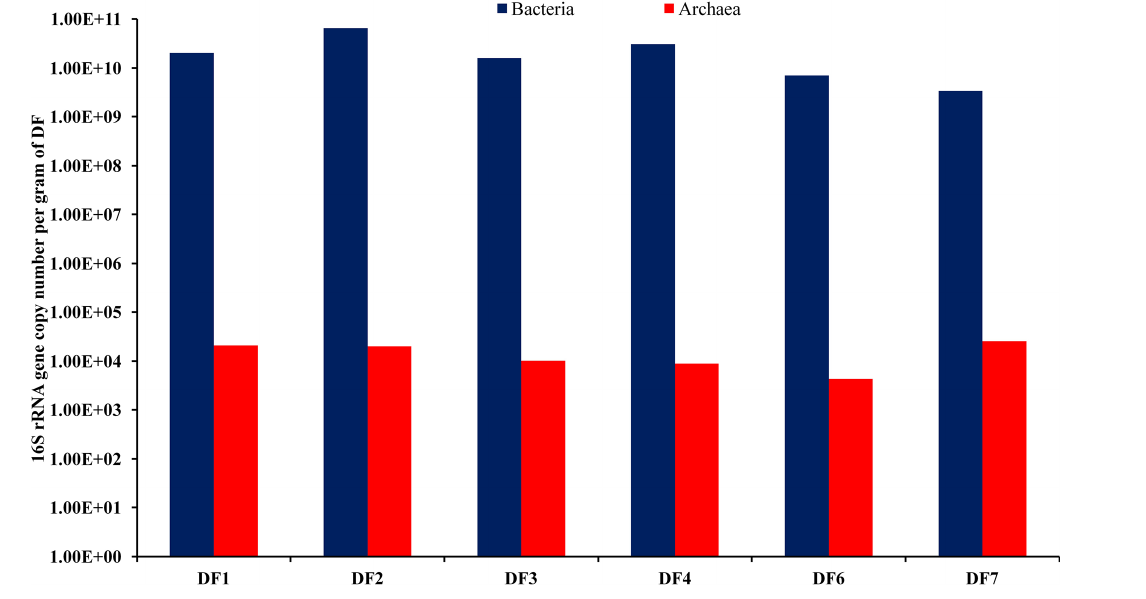
Figure 2. Archaeal and bacterial 16S rRNA gene copy number detected by